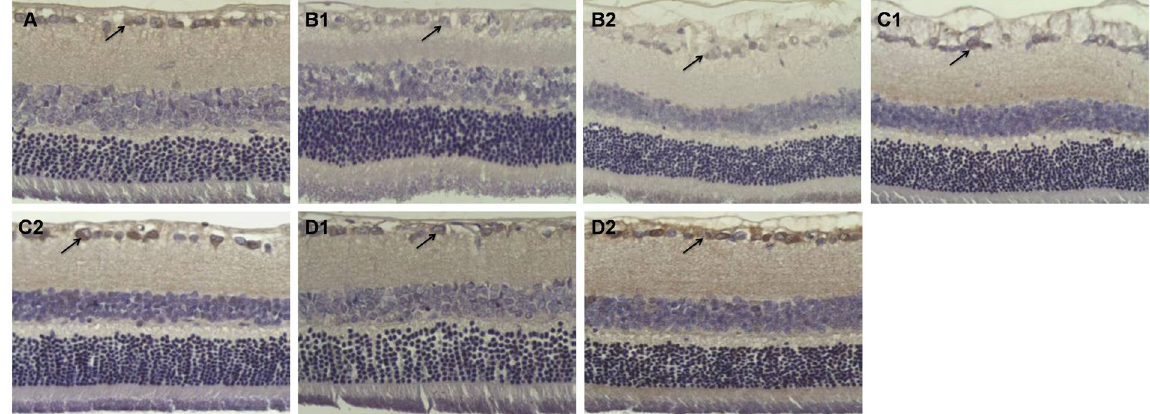
Figure 2. Expression of BDNF in the retina. ( A ) There were BDNF-positive cells in the ganglion cell layer and nerve fiber layer in Group A (arrow). Immunohistochemical staining 200 × . ( B ) Four and eight weeks following cell transplantation, the number of BDNF-positive cells in the ganglion cell layer and external nuclear layer was decreased in Group B (arrow). Immunohistochemical staining 200 × . ( C , D ) There was a marked increase in BDNF-positive cells in Groups C and D (arrow); the number increased specifically in Group D compared with Group C. Immunohistochemical staining 200 × .